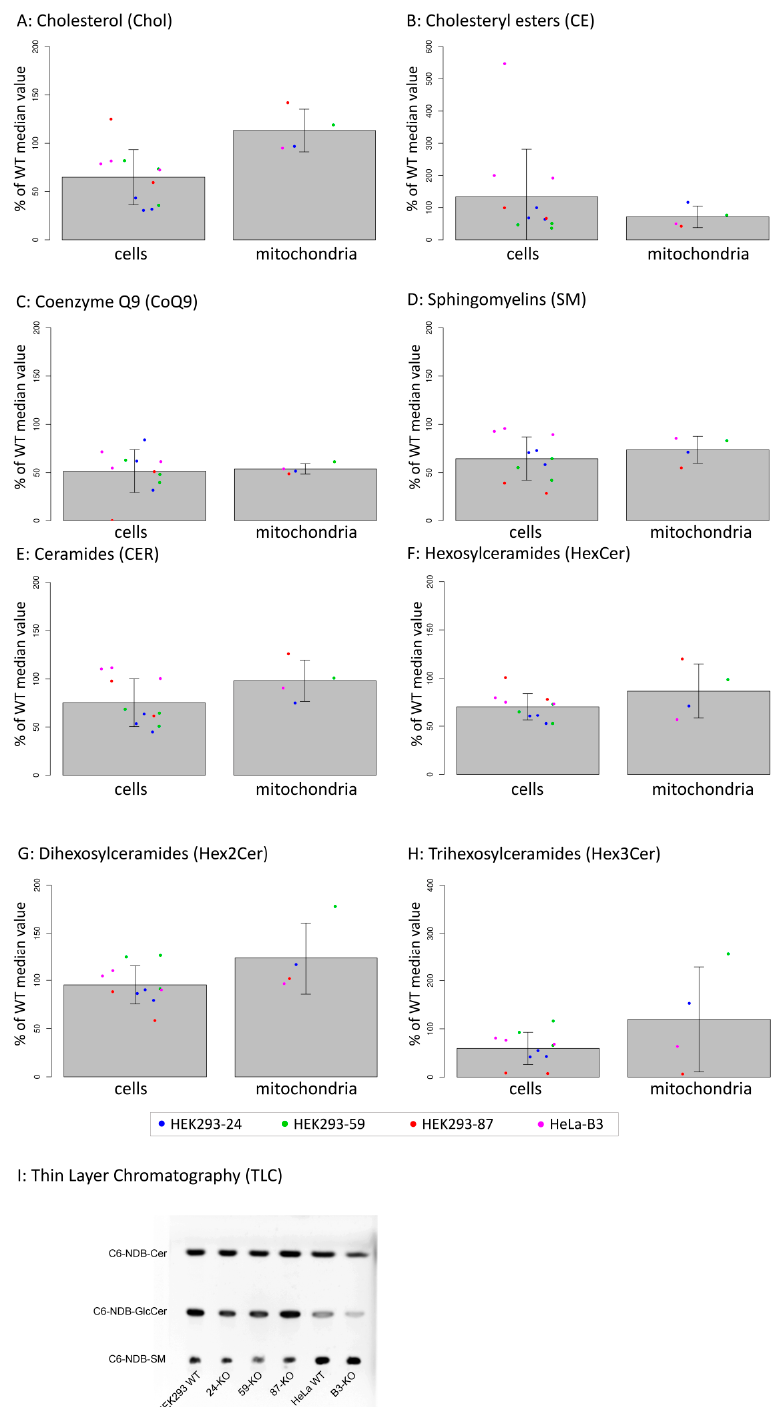
Figure 5. ( A – H ): Lipidomics analysis in whole cells and in isolated mitochondria of ACBD3-KO cells displayed as percentage of control values. Cells were measured in triplicate (duplicate in the case of 87-KO), dots represent individual obtained values, bar charts represent mean values, and errors bars represent SD. Significance of differences between WT and KO in cells and in mitochondria are summarized in Table 1. Linear mixed-effects models were used for statistical analysis. ( I ) In situ analysis of sphingomyelin synthase (SMS) and glucosylceramide synthase (GCS) activities using fluorescent-labeled ceramide (C6-NBD-Cer). Activities of SMS and GCS are visualized as the amount of synthesized products, sphingomyelin (C6-NBD-SM), and glucosylceramide (C6-NBD-GlcCer), respectively. Quantification of TLC results is shown in Figure